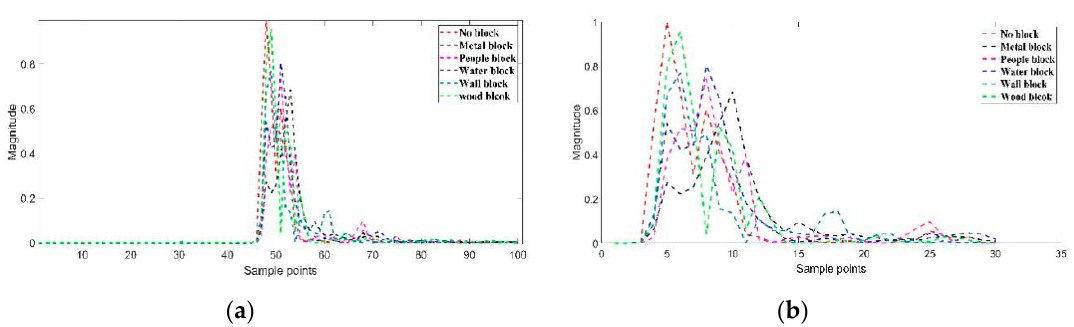
Figure 2. 1015 CIR signal points.